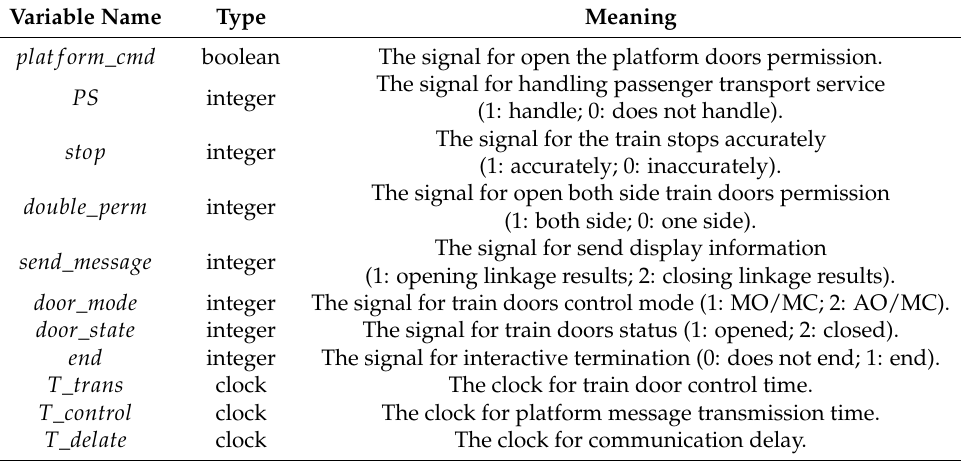
Figure 15. The TSRS model of the linkage control scenario of train doors and platform doors. Table 3. Variables in the TA